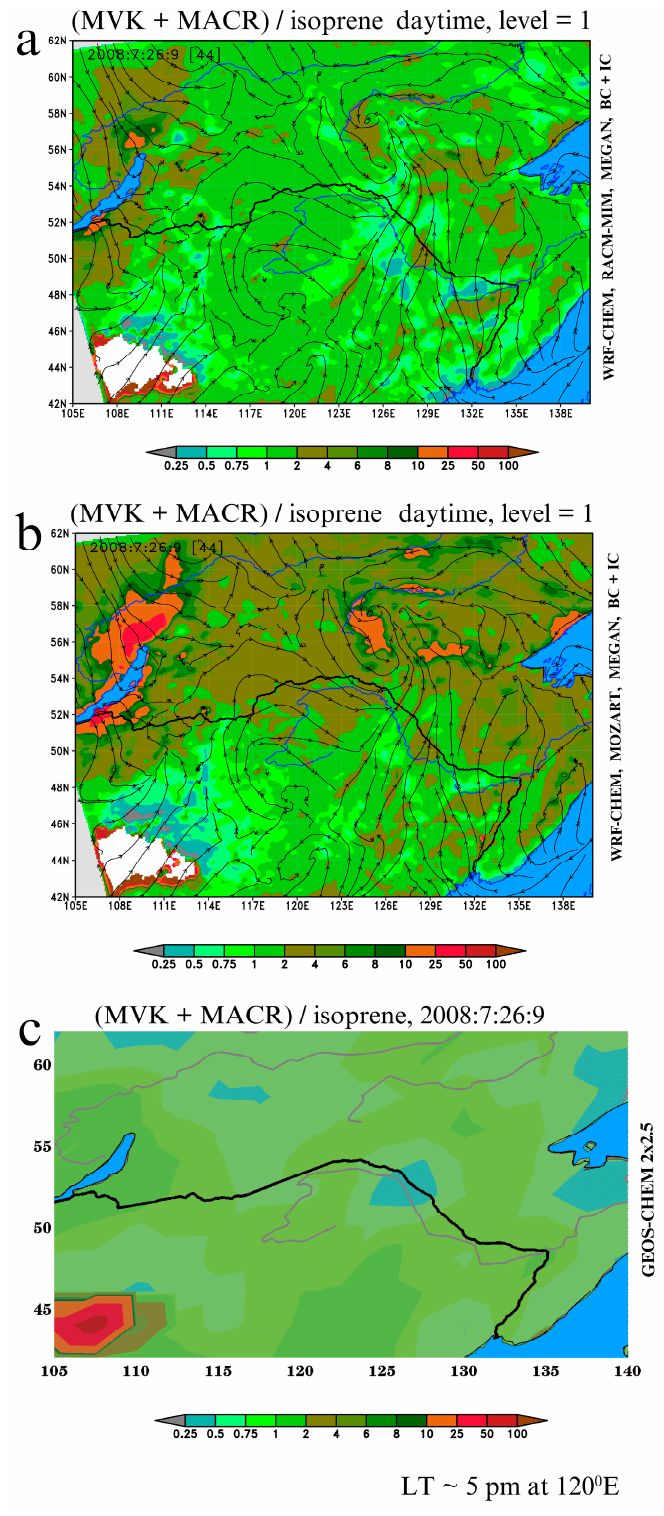
Figure 9. An example of the daytime chemical reaction maps of the ratio at 26.07.2008 09:00 UTC (~5 pm LT at 120 ◦ E), simulated by RACM-MIM ( a ) and MOZART gas-phase mechanisms ( b ) of the regional WRF-CHEM model and using the global GEOS-CHEM 2 × 2.5 ◦ model ( c ). In regional simulations, the long-range transport from the central industrial districts of China is taken into account. The white areas correspond to the values of the ratio >> 100, where isoprene is missing. In addition, the (u,v) streamlines at the surface level of WRF-ARW meteorological fields were presented in ( a , b ) to visualize the direction of species flows.